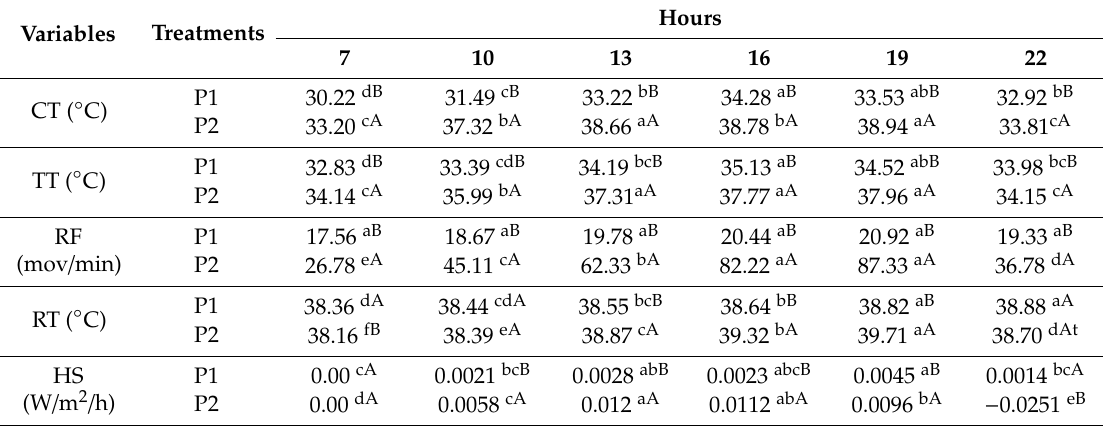
Table 1. Means of the physiological variables observed during P1 and P2 over the